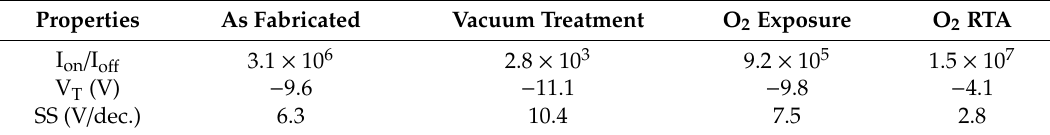
Table 1. Electrical properties of the ZnO TFT with di ff erent